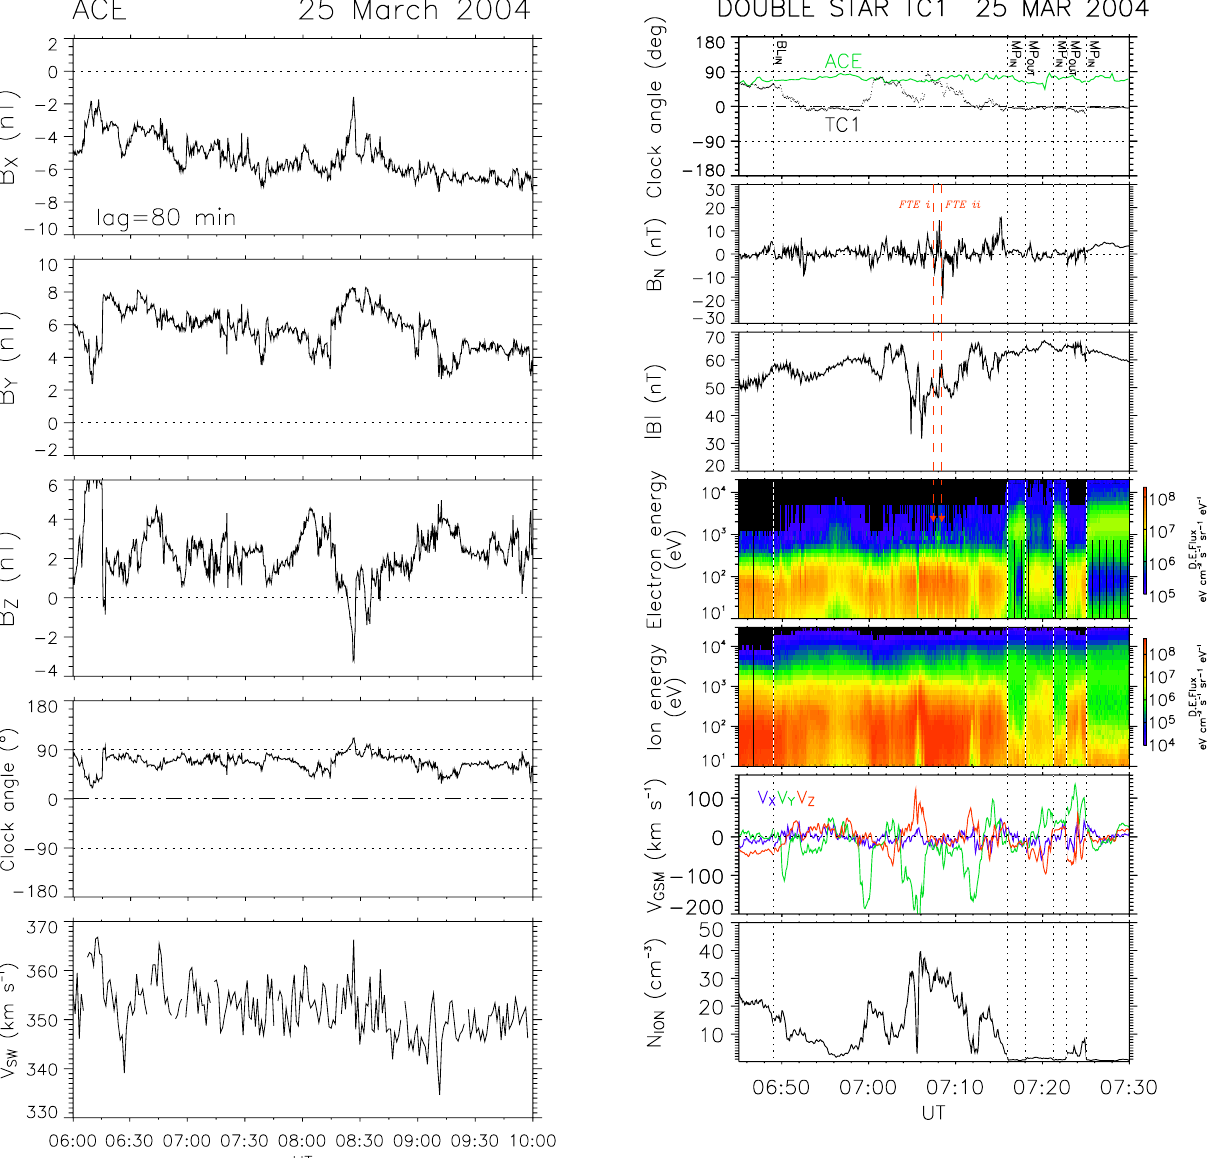
Fig. 4. Double Star field and plasma measurements between 06:45– 07:30. From top-to-bottom, the panels present; the magnetic field clock angle measured at TC1 (black) and ACE (green); the com- ponent of the magnetic field normal to the local magnetopause; the overall magnetic field strength; an energy-time spectrogram of elec- trons moving parallel to the local magnetic field; an ion energy-time spectrogram (all pitch angles); GSM V X (blue), V Y (green) and V Z (red) components of the ion bulk flow velocity; total ion density. Encounters with the boundary layer and magnetopause are indicated by dotted vertical line and labelled “BL” and “MP” respectively. The FTEs discussed in the text are indicated by dashed red